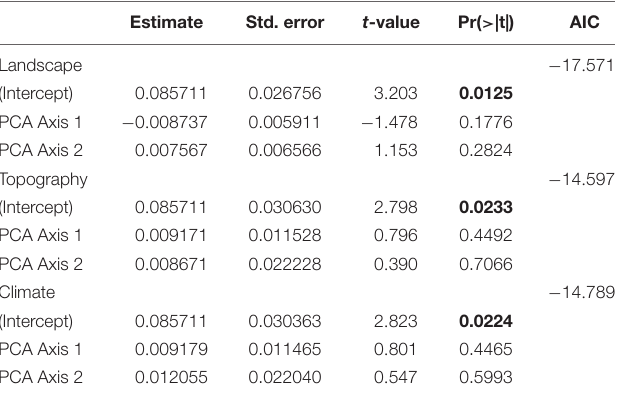
TABLE 2 | Coefficients resulting from Generalized Linear Models (GLM) where the proportion of drones infested with Varroa at the Drone Congregation Areas was the response variable.